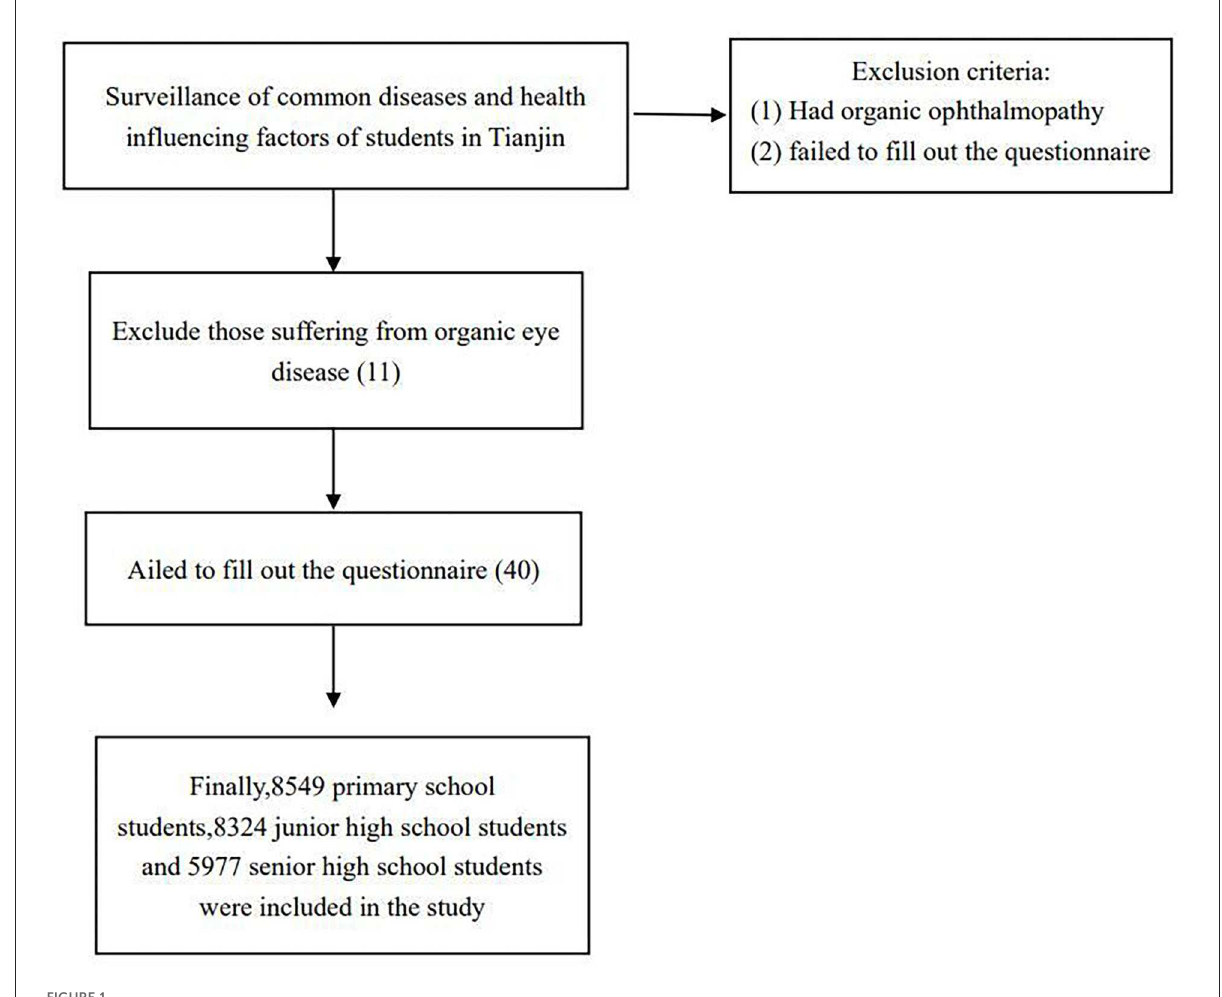
FIGURE1 Flow chart of inclusion and